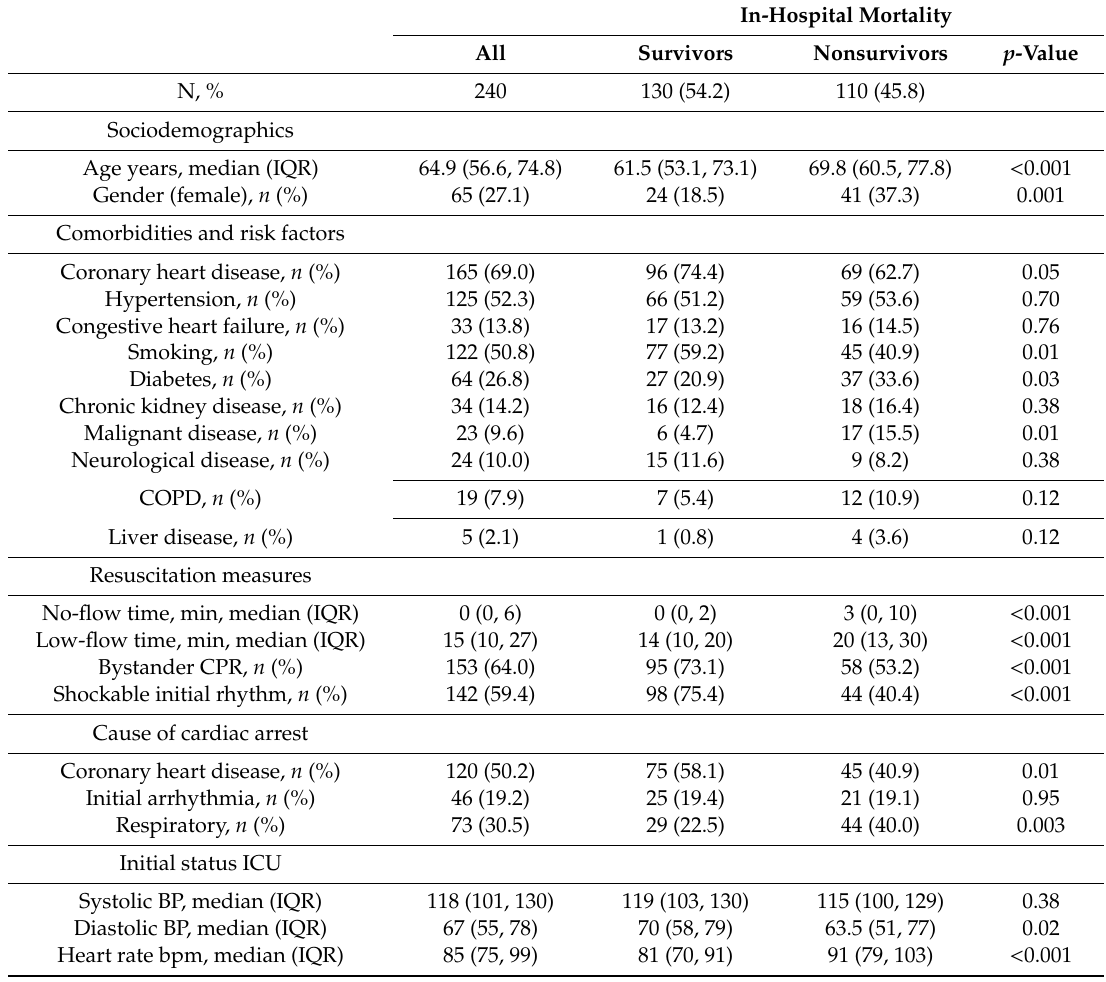
Table 1. Baseline characteristics of the primary endpoint